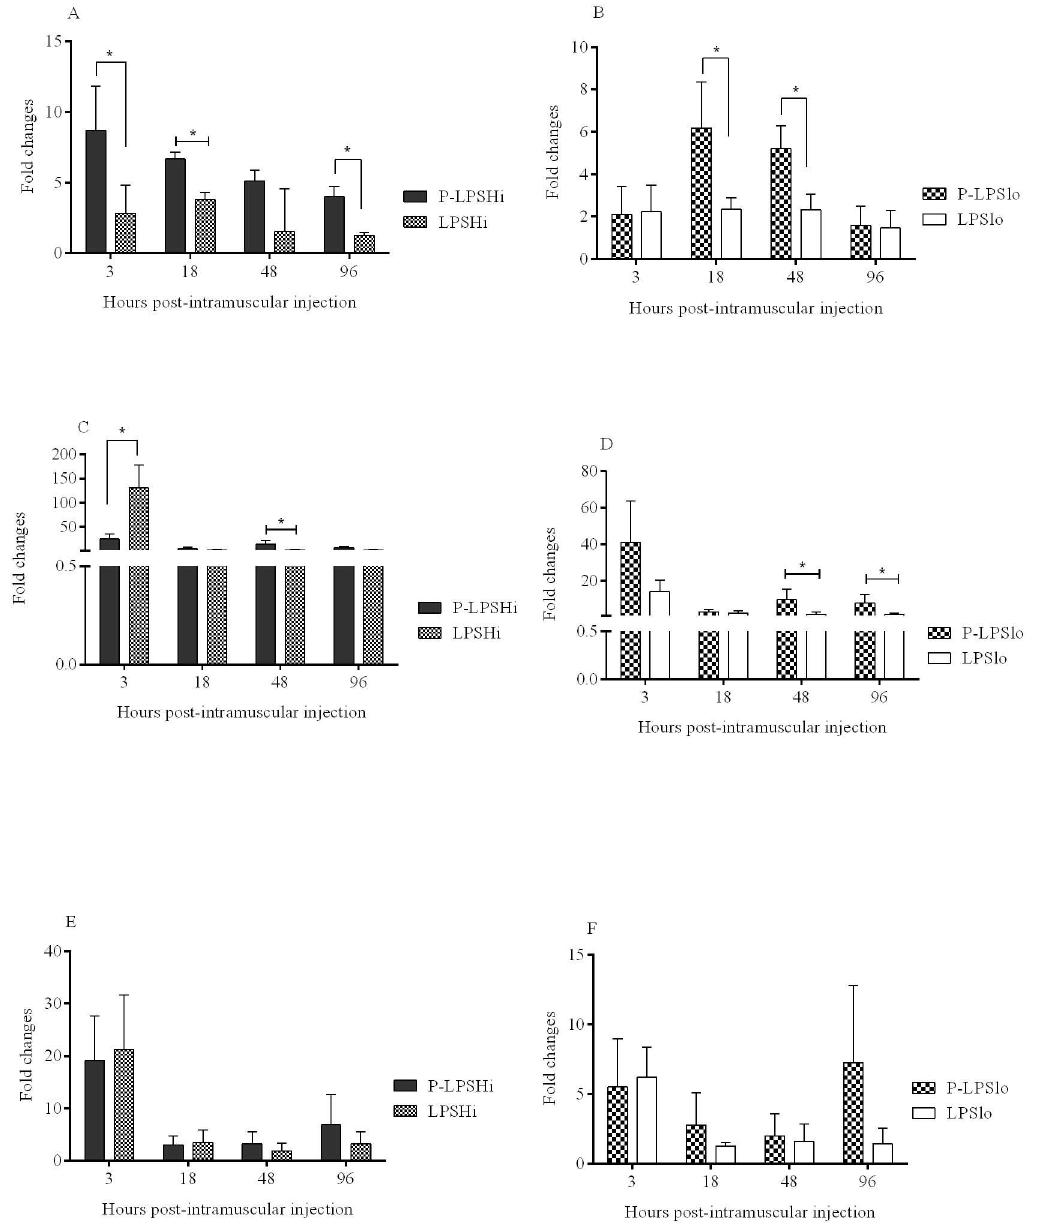
Fig 5. Quantification of IFN- γ (A, B), IL-1 β (C, D) and IL-8 (E, F) expression in spleen of chickens intramuscularly injected with encapsulated and soluble LPS. At 3, 18, 48 and 96 hr post-injection, spleenswere collectedand the relativeexpressionof cytokine geneswas determined.Bars represent mean fold expressionof cytokines in treated chickenscompared to the control chickens. Cytokine gene expressions were comparedbetween deliverysystems (encapsulated and soluble)within a dose and at a given time point. * indicatessignificantdifference at P <